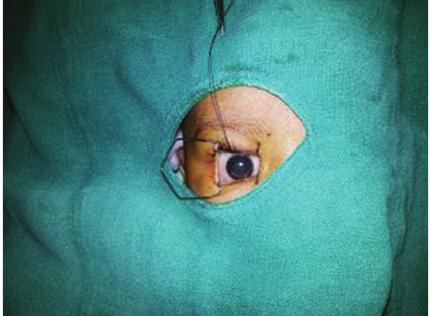
Figure 1: Child with cataract in the right eye.